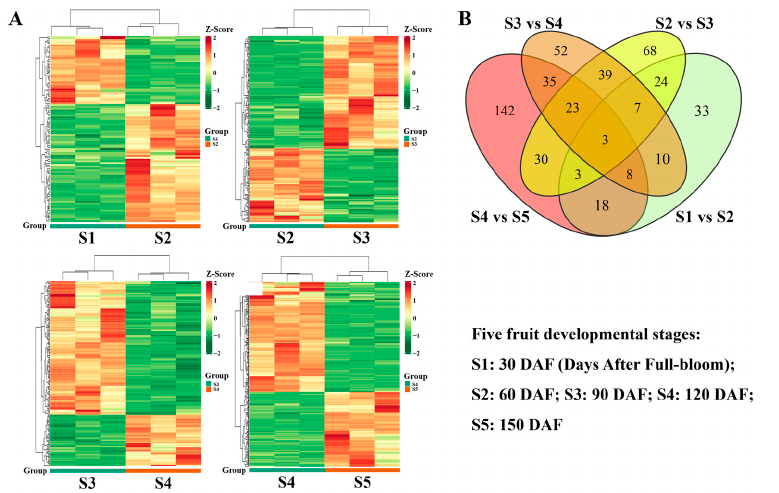
Figure 9. Differential accumulation of metabolites among the five stages of fruit development. ( A ) Heat map of differential metabolites between periods S1 and S2, S2 and S3, S3 and S4, and S4 and S5 (three independent replicates of each phase are shown); ( B ) Venn diagrams of differential metabolites between periods S1 and S2, S2 and S3, S3 and S4, and S4 and S5. In total, 106 significantly differential metabolites were identified between S1 and S2, including 67 upregulated and 39 downregulated metabolites (Table 1, Figure S6), indicat- ing that more differential metabolites were upregulated (rather than downregulated) dur- ing the early fruit expansion stage. In the comparison of S2 versus S3, 197 significantly differential metabolites were detected (119 were upregulated and 78 were downregu- lated), representing a significant increase in the number of differential metabolites and indicating that numerous metabolites accumulated in the fruit as it developed. In contrast, the number of differential metabolites between S3 and S4 was slightly lower than in the previous stage; it included more downregulated metabolites (S3 vs. S4, 177 significantly differential metabolites: 49 upregulated and 128 downregulated), suggesting that many differential metabolites were involved in the transition from the early fruit development expansion stage (S3) to the early fruit ripening stage (S4). Furthermore, the number of differential metabolites significantly increased between S4 and S5 (S4 vs. S5, 262 signifi- cantly differential metabolites: 106 upregulated and 156 downregulated), indicating that many metabolites accumulated in the fruit during the ripening stage (S5) (Table 1, Figure S6). The heat maps of differential metabolites in each of these four combinations clearly demonstrate these trends (Figure 9A). Additionally, the numbers of differential metabo- lites were compared among these four combinations using a Venn diagram (Figure 9B). As illustrated in Figure 9B, three groups of differential metabolites were associated with the four combinations. Overall, 37 differential metabolites were present between S1 vs. S2 and S2 vs. S3, 72 differential metabolites were present between S2 vs. S3 and S3 vs. S4, and 69 metabolites were present between S3 vs. S4 and S4 vs. S5. To explore the biological processes associated with the differential metabolites, me- tabolites were assigned to KEGG pathways (Figure S7). As shown in Figure S7, the differ- ential metabolites between S1 and S2 were significantly associated with ABC transporters, arginine and proline metabolism, butanoate metabolism, and purine metabolism (Table S5). Differential metabolites between S2 and S3 were significantly associated with the TCA cycle, linoleic acid metabolism, flavonoid biosynthesis, and phenylpropanoid biosynthe- sis. Differential metabolites between S3 and S4 were significantly associated with